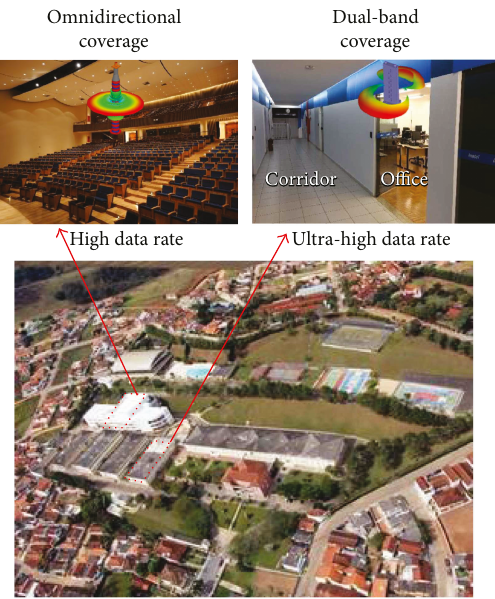
Figure 1: Typical scenarios of indoor 5G networks, illustrated at the INATEL